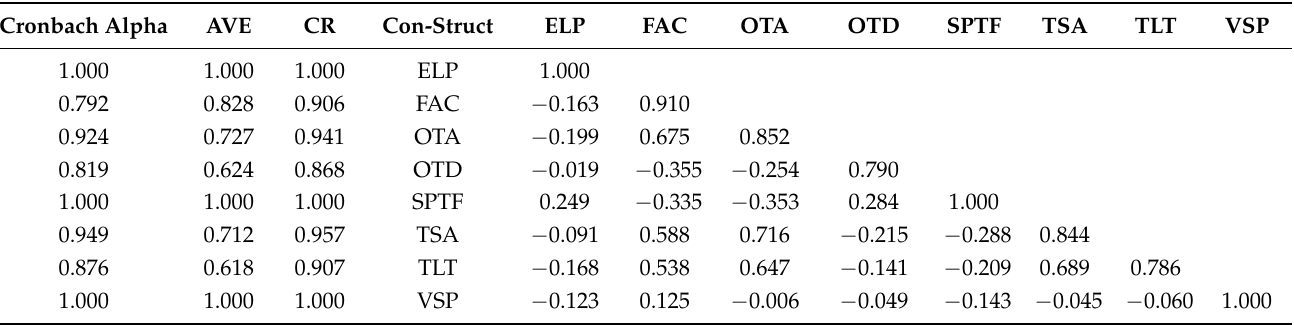
Table 2. Discriminant validity analyses (Fornell–Larcker criterion).